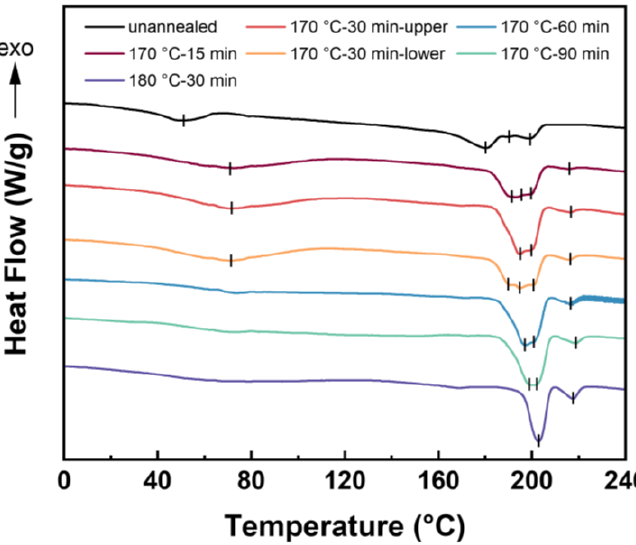
Figure 11. DSC curves of HD-TPU foams prepared at various saturation times. The saturation temperatures were 170 and 180 ◦ C and saturation pressure was 15 MPa.